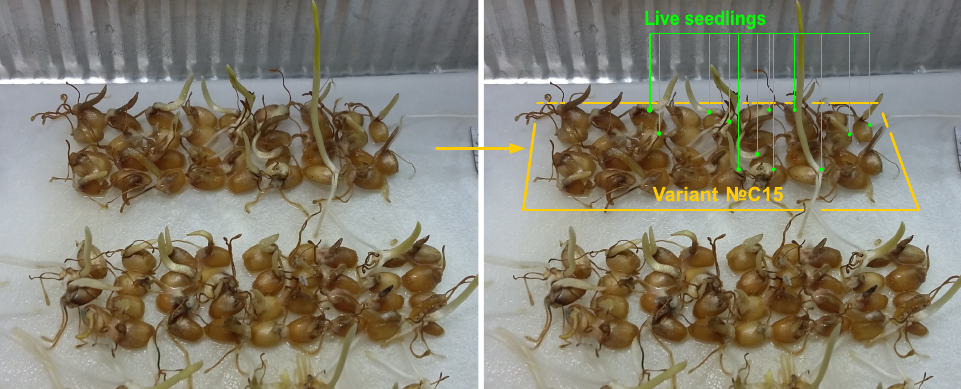
Figure 4. Example of seedling count for determination of the relative frost resistance. Live seedlings are marked by green